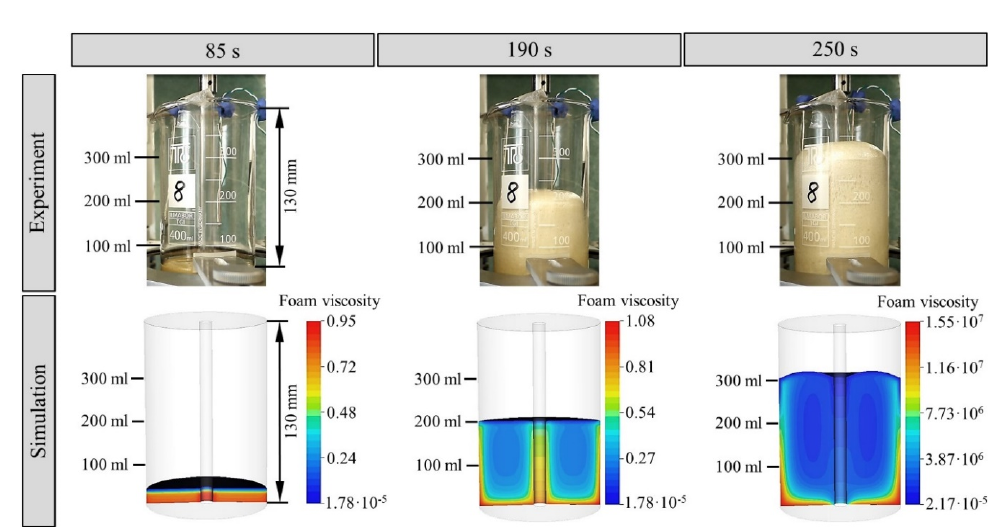
Figure 10. Comparison between real and simulated PUR foam expansion in the rheometer test